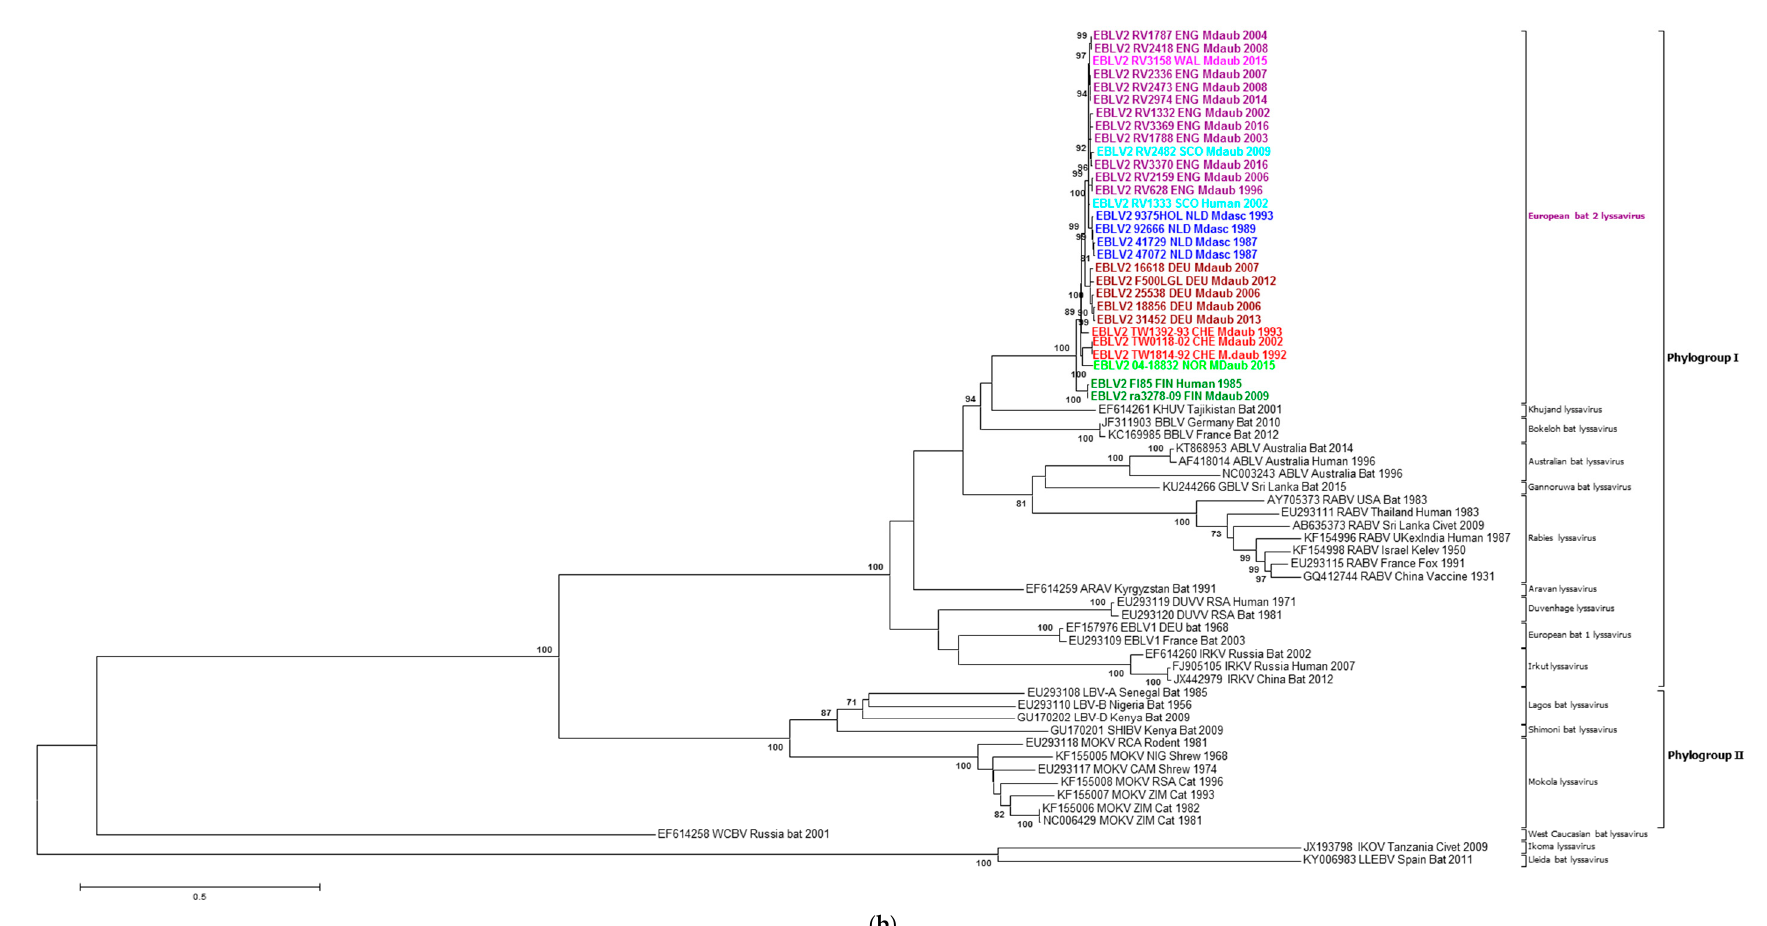
Figure 2. Molecular phylogenetic analysis of ( a ) nucleoprotein sequences (1353 nucleotides) and ( b ) glycoprotein sequences (1569 nucleotides) from 29 EBLV-2 cases and 36 non EBLV-2 lyssavirus sequences ( n = 65). Sequences were analysed by the Maximum Likelihood method. Bootstrap values > 70% are shown for each branch and analysis was performed using the GTR + G + I model in MEGA6 with 1000 bootstrap samples. The EBLV-2 sequences are coloured depending upon sampling location (see 3 letter codes within case names) ( a ) N1353; ( b ) G1569.